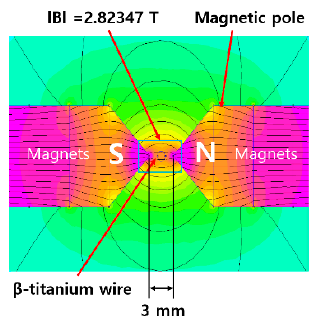
Figure 5. Surface roughness (Ra) vs. processing time as a function of rotational speed (vibration: 8 Hz; abrasive: 1 μ m; sharp edge; gap: 3 mm).